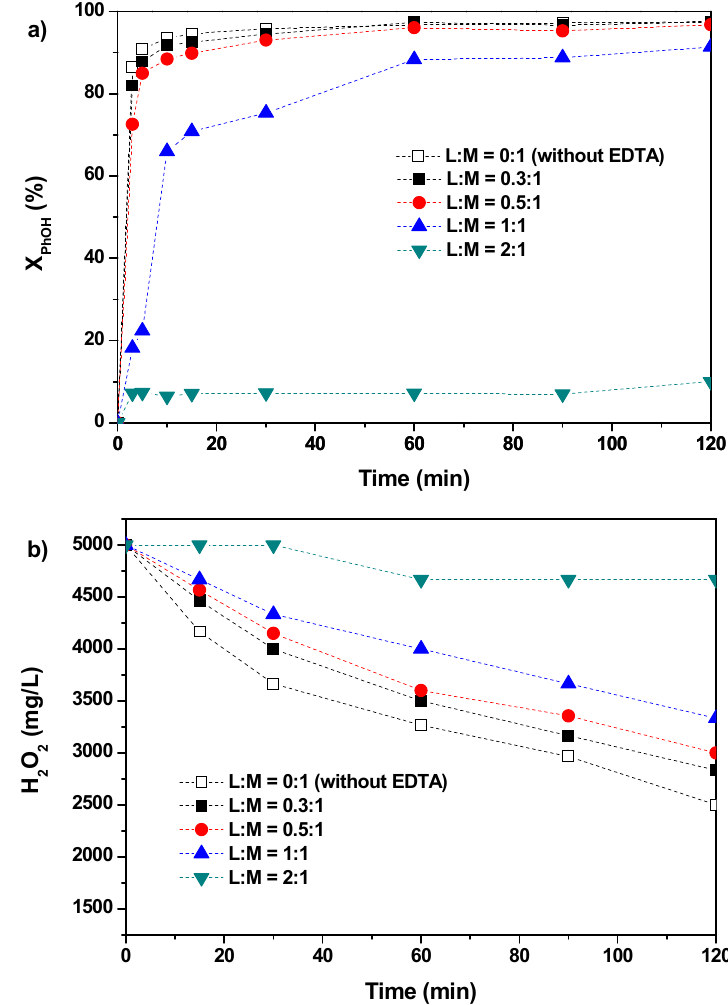
Figure 1. Phenol ( a ) and H 2 O 2 ( b ) conversion versus time for different EDTA:Fe molar ratios. [Phenol] = 1000 mg / L, [H = 5000 mg / L, [Fe 2 + ] = 7 mg / L, T = 30 ◦ C, [pH] 2 O 2 ] 0